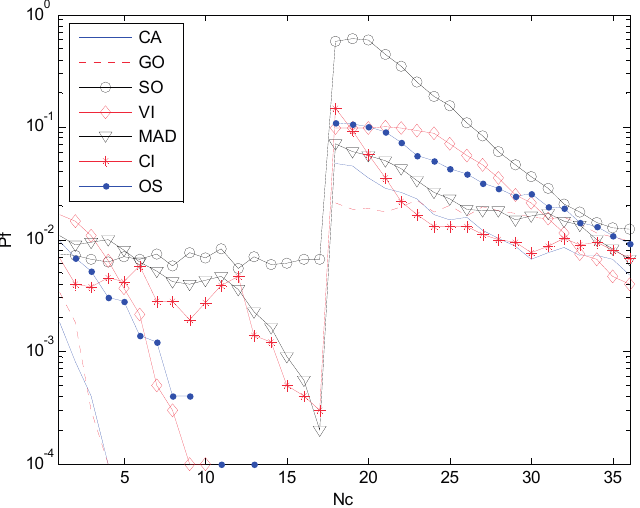
Figure 16. The false alarm performance in clutter edge